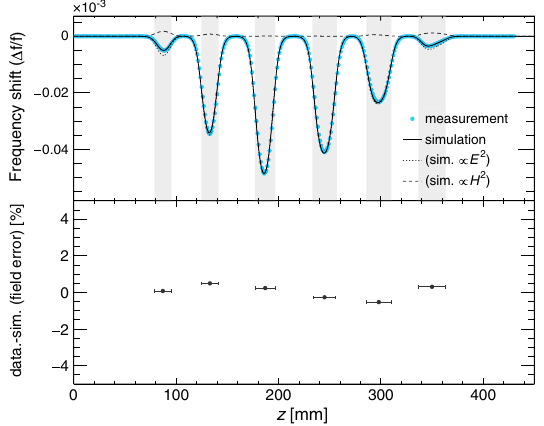
FIG. 9. Frequency shift distribution obtained with the bead pull measurement. Top: the measured and simulated frequency shift. The gray bands show the gap regions. Bottom: the difference between the measurement and the simulation (field error) in the gap region.